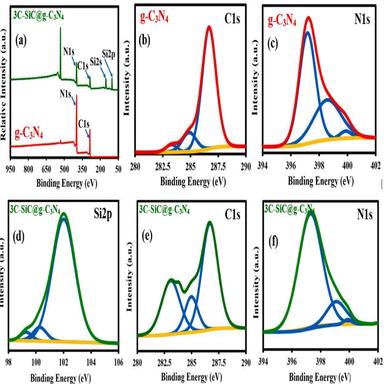
XPS survey scans of g-C3N4, and 10%-3C–SiC@g-C3N4 (a) deconvoluted C1s Peak of g-C3N4 (b), deconvoluted N1s Peak of g-C3N4 (c) deconvoluted Si 2p peak of 10%-3C–SiC@g-C3N4 (d) deconvoluted C1s Peak of 10%-3C–SiC@g-C3N4 (e) and deconvoluted N1s Peak of 10%-3C–SiC@g-C3N4 (f).